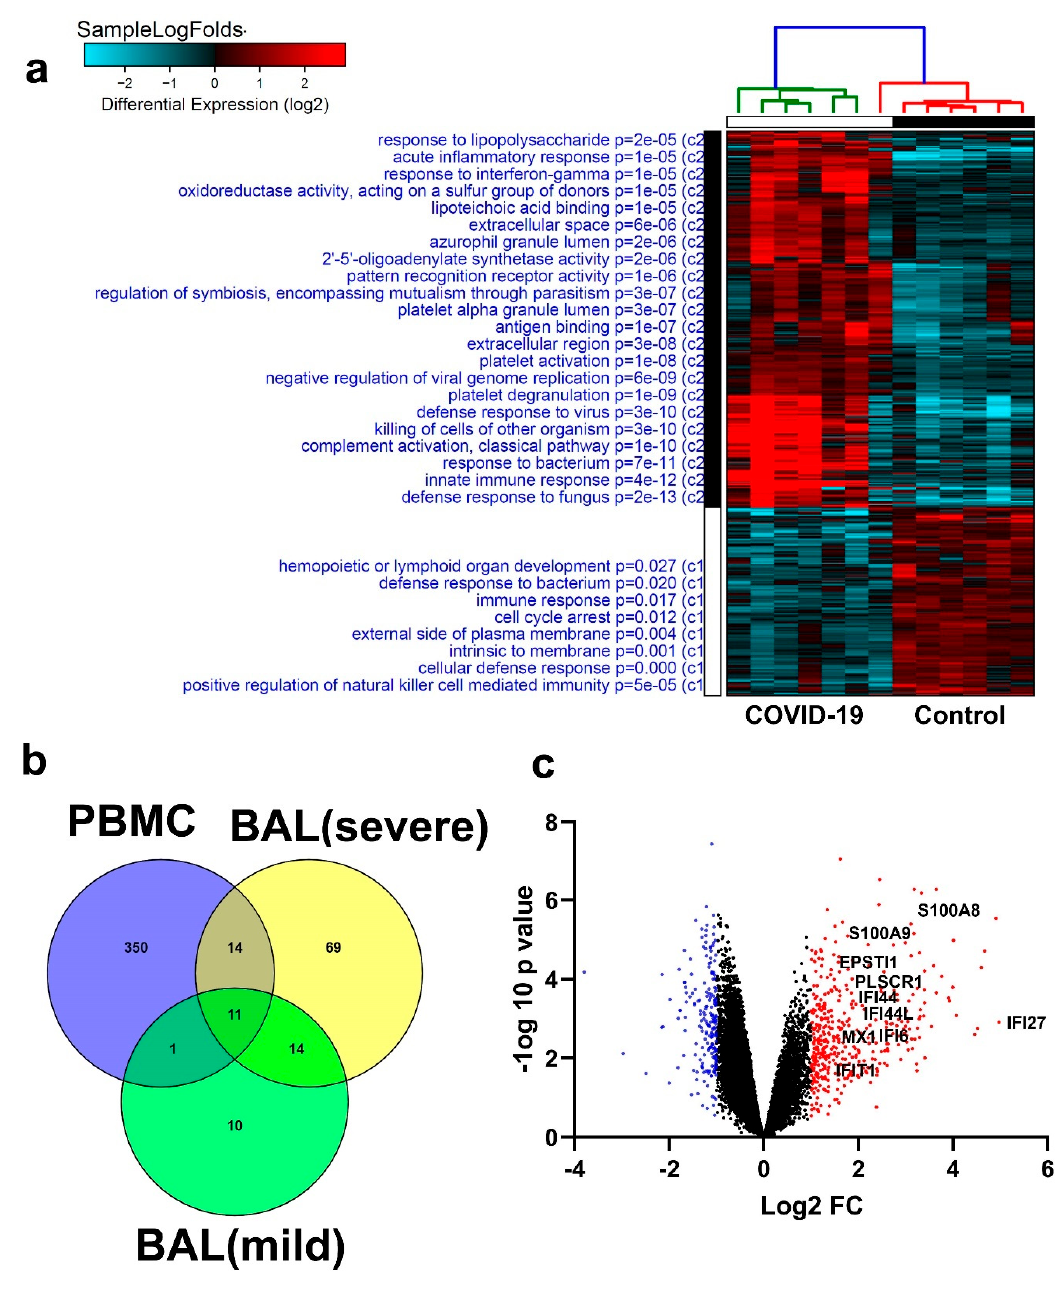
Figure 9. Similarities in transcriptome data from BAL and peripheral blood mononuclear cell (PBMCs) in COVID-19 patients. ( a ) Hierarchical clustering summarizing differential gene expression (log2) in PBMCs from COVID-19 and normal controls, highlighting enriched functional categories (GO). ( b ) Venny diagram illustrating the aberrantly expressed genes in common in severe- and mild-Covid-19 BAL and PBMC, with 11 genes in common to the three categories. ( c ) Volcano plot depicting selected genes common to BAL and PBMCs, indicating upregulated (red) and downregulated (blue) genes.